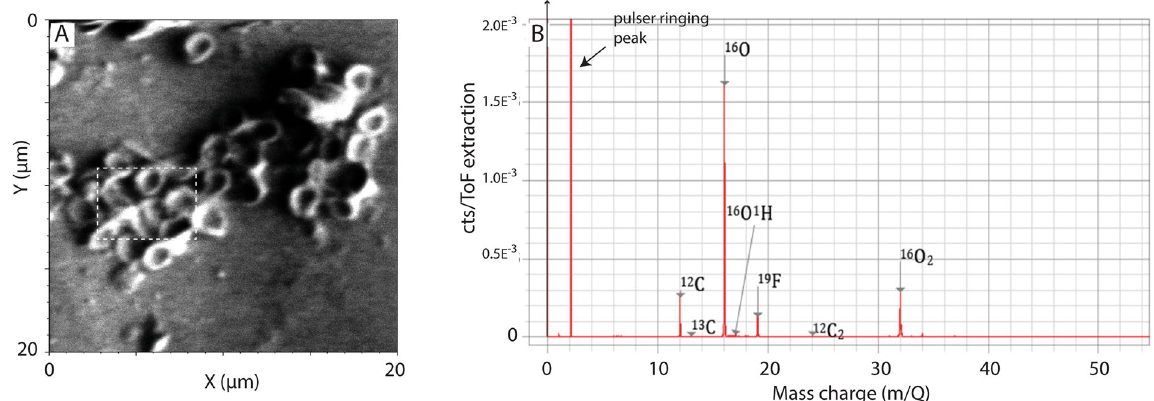
Figure 5. ToF -SIMS analysis of RBC-like structures in the ichthyosaur vertebra. ( A ) Secondary image of the RBC-like structures by ToF-SIMS. The white rectangle correspond to the area where the mass spectra was acquired. ( B ) Negative ions mass spectra showing the presence of C, O and Fluorine (F) specifically associated with the RBC-like